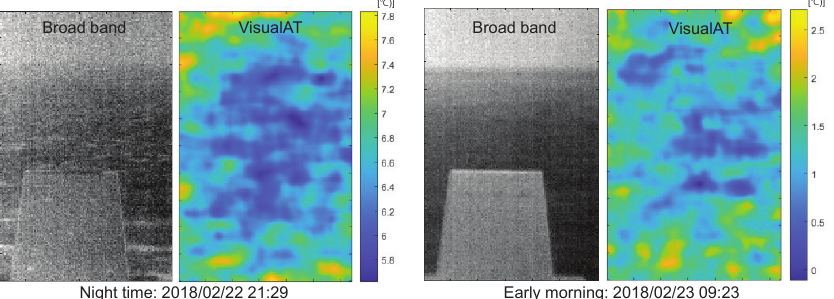
Figure 25. Example of visual air temperature images at night and in the morning: (left) night time air temperature image at 21:29; (right) early morning temperature image at